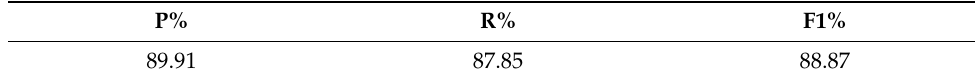
Table 4. Bi-LSTM-CRF named entity recognition model results.